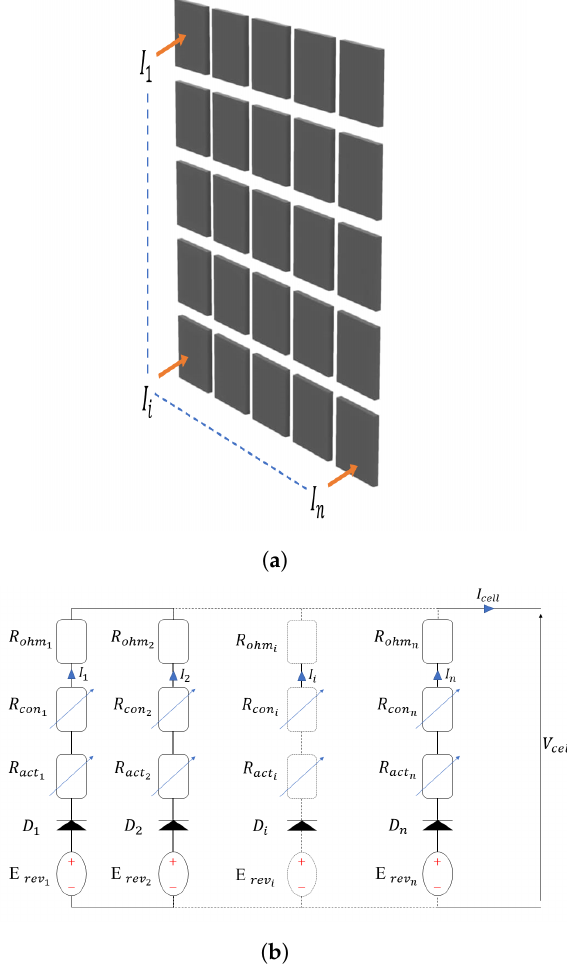
Figure 3. Discretized current density corresponding to n surface elements at the electrolyte level (a), electric circuit representation for the current density distribution inside FC (b)